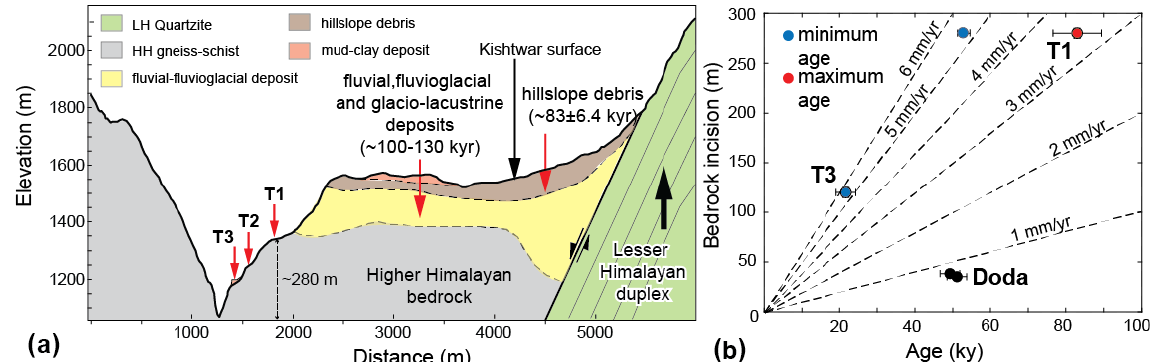
Figure 10. (a) A topographic and geomorphic profile across the Chenab valley drawn over Kishtwar. The valley aggradation by fluvioglacial and hillslope debris sediments was succeeded by a fluvial incision, which penetrated through the unconsolidated sediments to a thickness of ∼ 140–150m and incised Higher Himalayan bedrock by ∼ 280 ± 5m, leaving behind at least three recognizable strath surfaces with a thin late Pleistocene sediment cover. The three strath surfaces are at 280 ± 5m (T1), ∼ 170m (T2) and ∼ 120 ± 5m (T3) heights from the present- day river. We assume that the present-day bedrock gorge has been carved since the deposition of the glacio-lacustrine sediment deposits ( ∼ 100–130ka) and the hillslope debris ( ∼ 90–80ka) onto the former fluvial strath surface of Higher Himalayan Bedrock. The width of the fluvial strath surface where Kishtwar is located indicates that the river network had been dammed earlier too. (b) Graphical representation of mean bedrock incision rates since 80ka. Age constraints for T3 are shown in Fig. 4a. Based on the relative heights and depositional ages of late Pleistocene deposits, we propose a minimum and a maximum bedrock incision rate of 3.1–3.5 and 5.2–5.6mmyr − 1 , respectively. In contrast, the bedrock incision rates calculated from bedrock straths further downstream from the KW range 0.7–0.8mmyr − 1